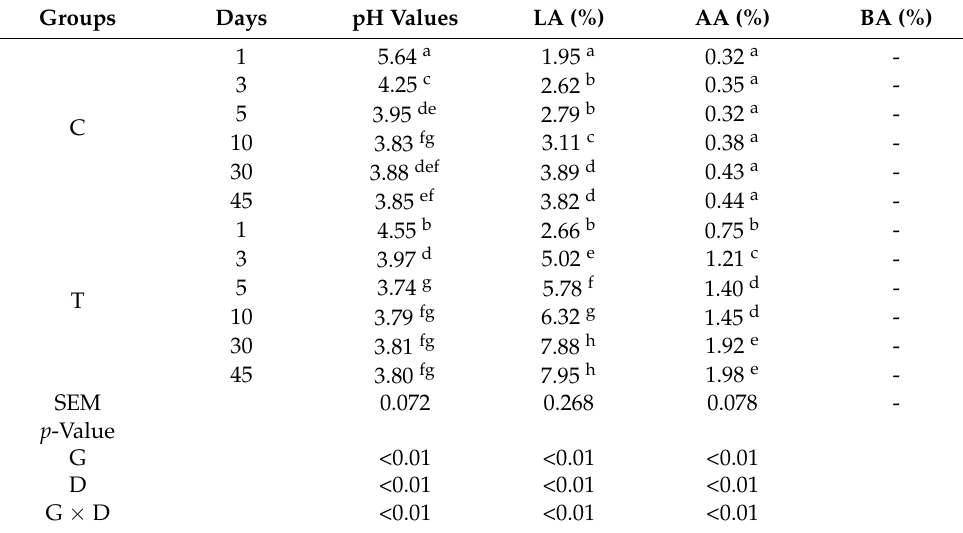
Table 1. Dynamic changes in the pH and organic acids in the two groups during the ensiling process. Groups Days pH Values LA (%) AA